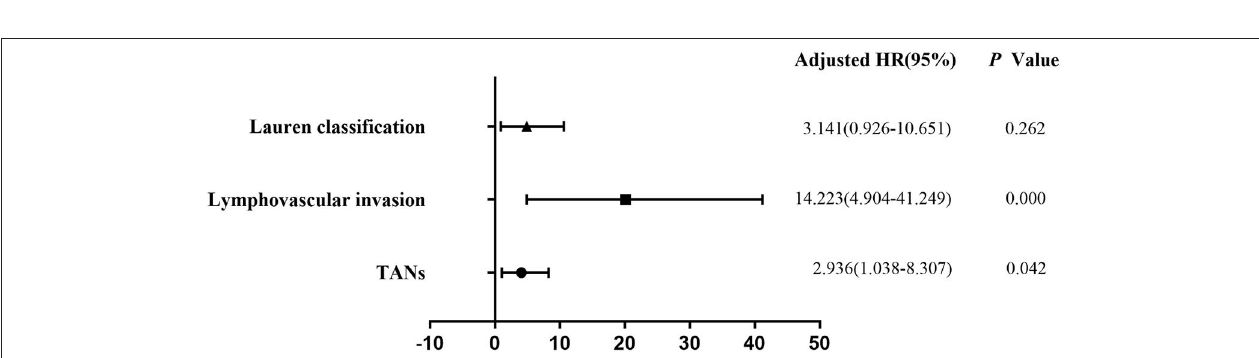
FIGURE 4 | Multivariate logistic regression analysis of potential risk factors for LNM in patients with SM2 EGC. Stratification analysis indicated that both LVI ( P = 0.000) and TANs ( P = 0.042) were the independent factors for SM2 tumors.